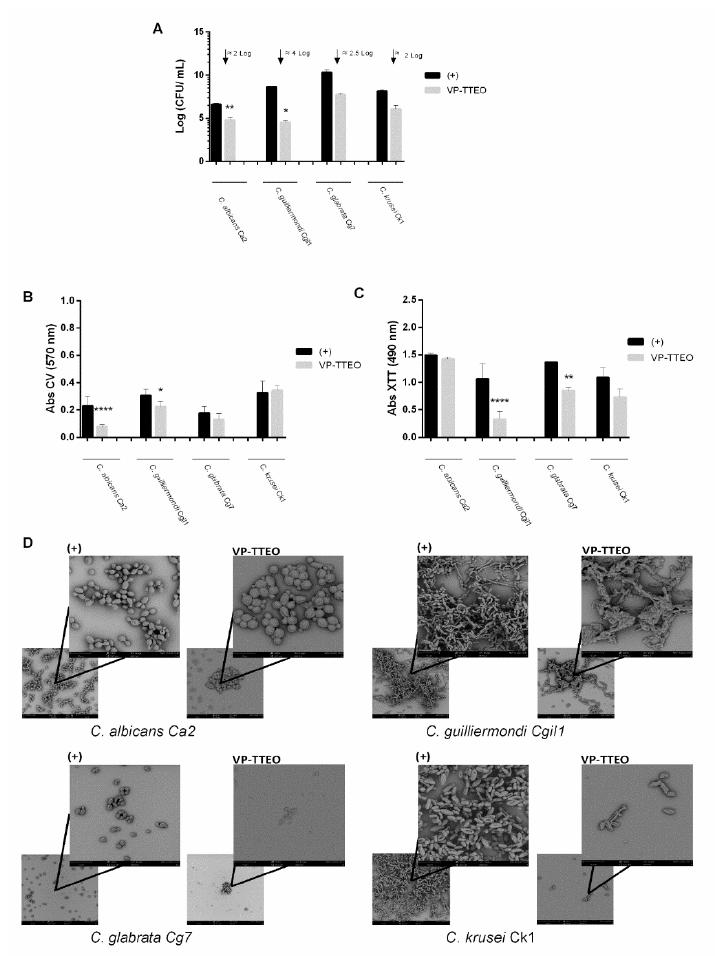
Figure 2. Effect of the vapor phase of tea tree essential oil (VP-TTEO) on the biofilm formation of antifungal-resistant Candida isolates. Biofilms of C. albicans Ca2, C. guilliermondii Cgi1, C. glabrata Cg7, and C. krusei Ck1 were developed in the absence (control) and presence of the VP-EOs: ( A ) Number of cultivable cells (Log CFU/mL). ( B ) Absorbance values of crystal violet solutions (Abs CV) and ( C ) absorbance values of XTT solutions (Abs XTT). * indicates statistical reduction in biofilms cell cultivability in comparison with the respective control (* p < 0.1, ** p < 0.01, **** p < 0.0001). ( D ) Scanning electron microscope (SEM) images. The bar represents 30 µm (lower magnification image) or 10 µm (higher magnification image).